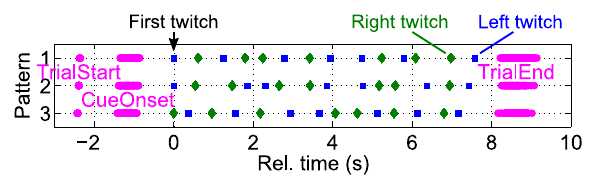
FIGURE 3 | Pseudo-randomized twitch patterns. To ensure that twitches would not occur closer than 250ms, three different randomized twitch patterns were generated beforehand for all possible stimulation frequency combinations (here: 33 and 27Hz). In each trial, one of these three pattern was randomly chosen. Left (blue squares) and right (green diamonds) twitch positions, as well as trial start, cue onset, and trial end (magenta bullets) are shown for individual trials, aligned to the first twitch’s positions ( t =